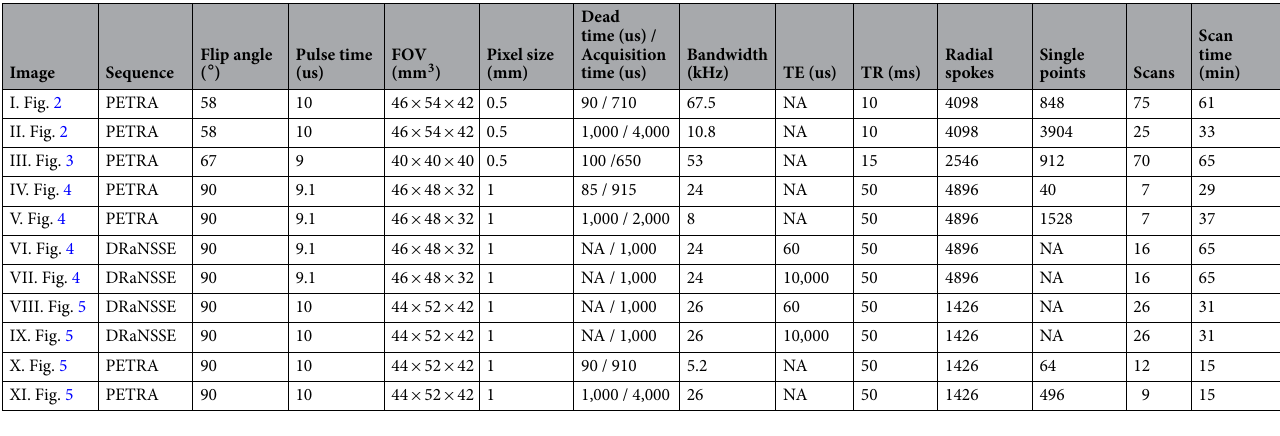
Table 1. Image acquisition parameters. “NA” stands for “not applicable”.